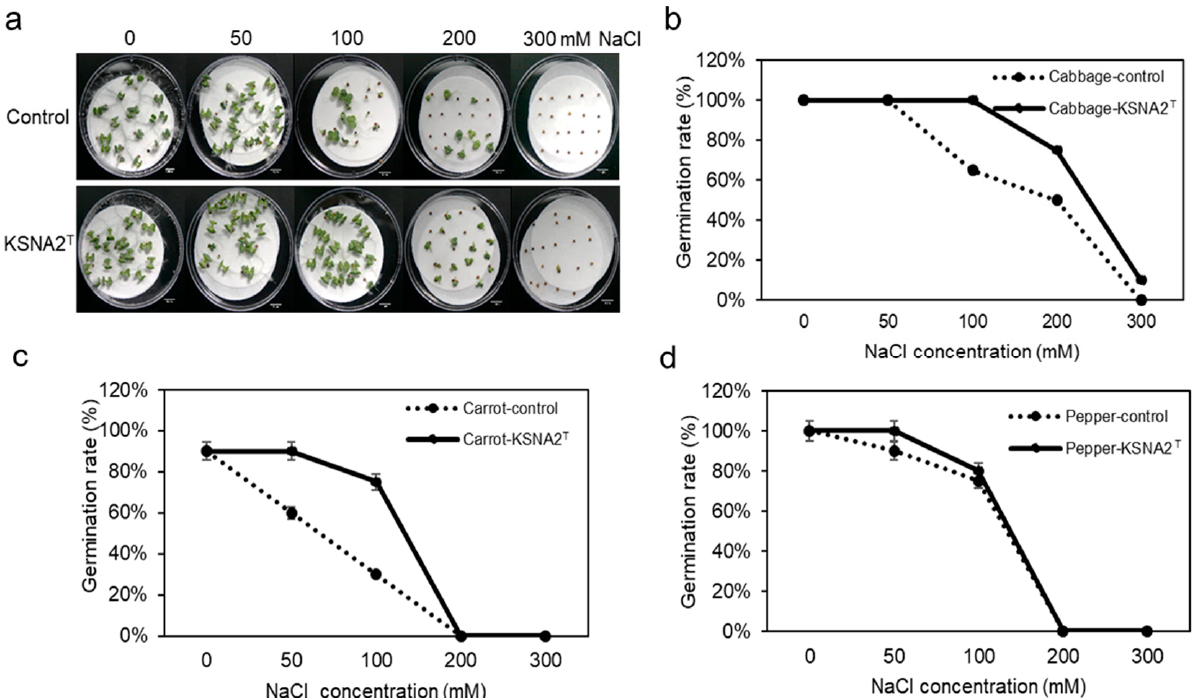
Figure 3. Effects of treatment with strain KSNA2 T on seeds grown in different salt concentrations. The germination rates of seeds in various concentrations of NaCl (0, 50, 100, 200, and 300 mM) were calculated after seven days. Seeds were inoculated with the KSNA2 T bacterial suspension (10 8 CFU/mL) and without (Tryptic Soy Broth (TSB) media, control) for 12 h. ( a ) Seedling growth in cabbage. The average germination rate of ( b ) cabbage, ( c ) carrot, and ( d ) pepper. Scale bar = 1 cm.